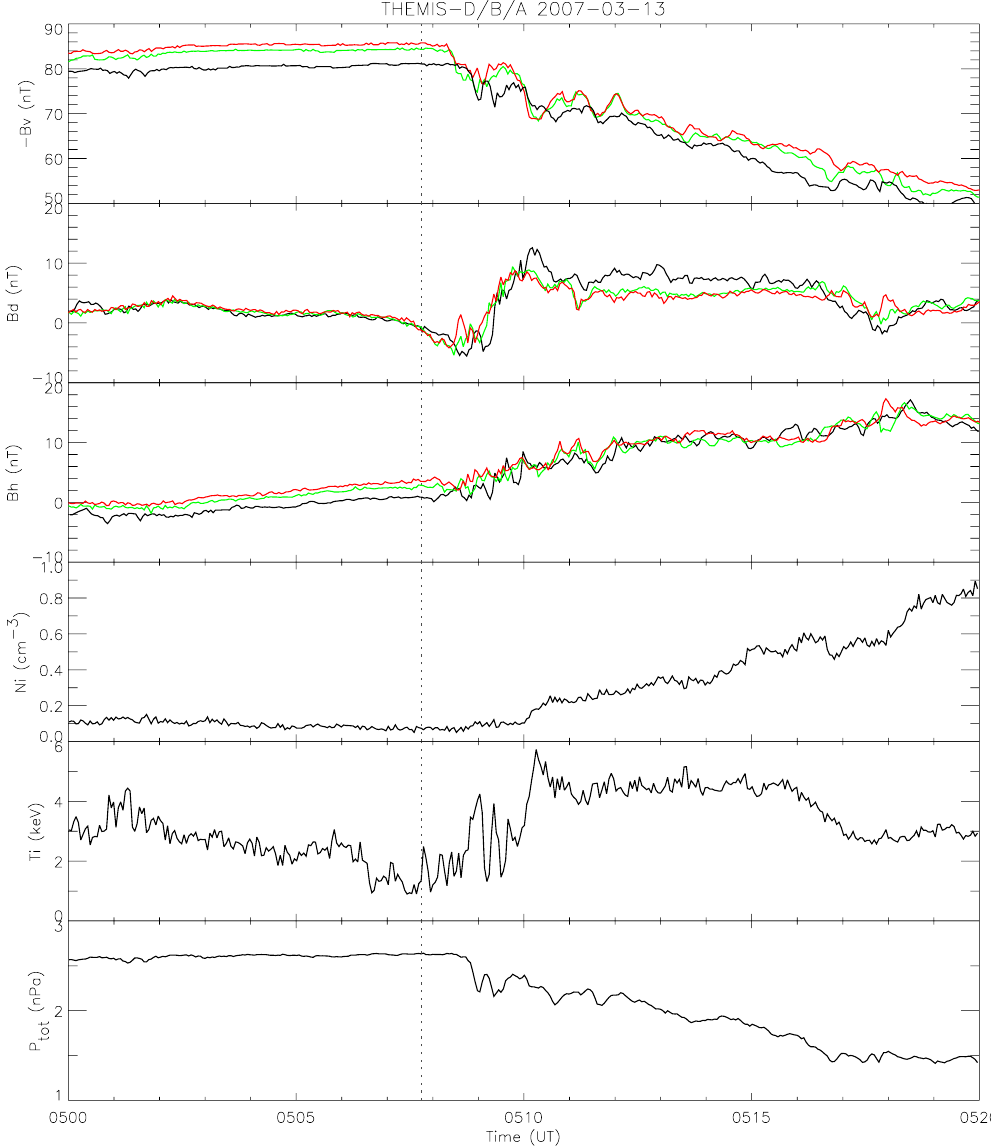
Fig. 1. THEMIS observations for 13 March 2007 event. The first three panels give the magnetic fields in VDH coordinates from TH-D (red), TH-B (green), and TH-A (black) probes. The 4th to 6th panels show the ion number density, ion temperature and total pressure on TH-A,